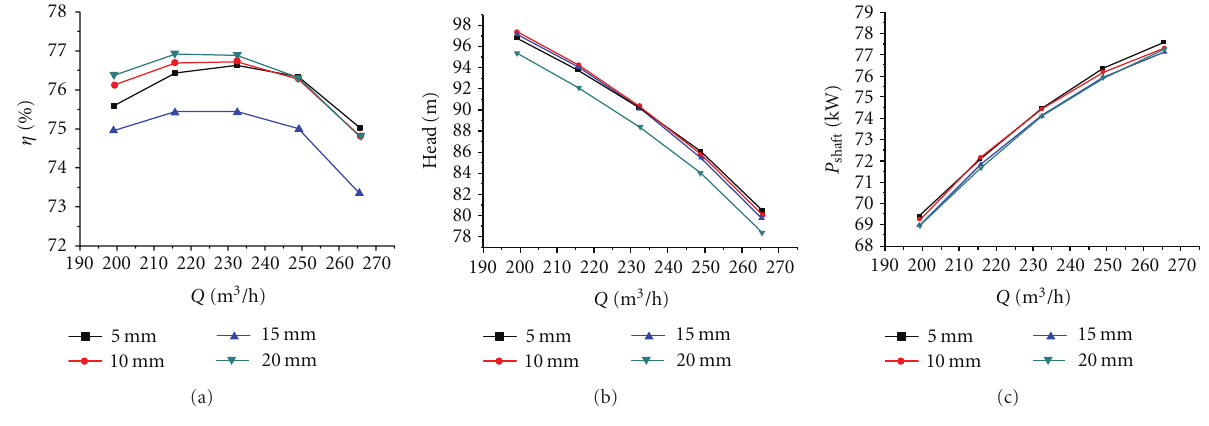
Figure 9: (a) Q - η curve, (b) Q - H curve, and (c) Q - P shaft curve. Table 5: List of pump BEPs with di ff erent radial